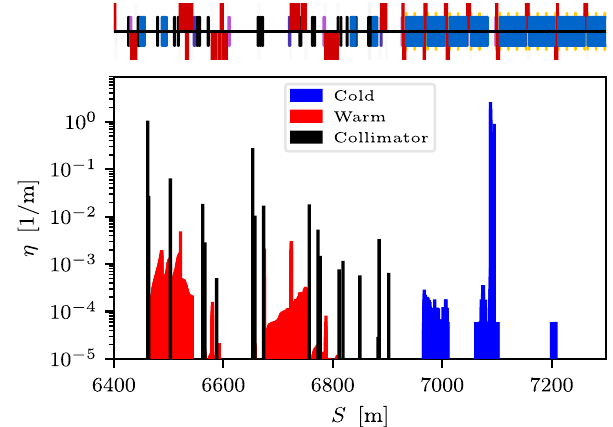
FIG. 5. S ix T rack – FLUKA simulation results for Beam 2. The presence of an excess losses in the first cell after the dispersion suppressor (around S ¼ 7100 m) is visible, as for the case of Beam 1 (see Fig. 4). Note, the S coordinate now is counter- clockwise from the